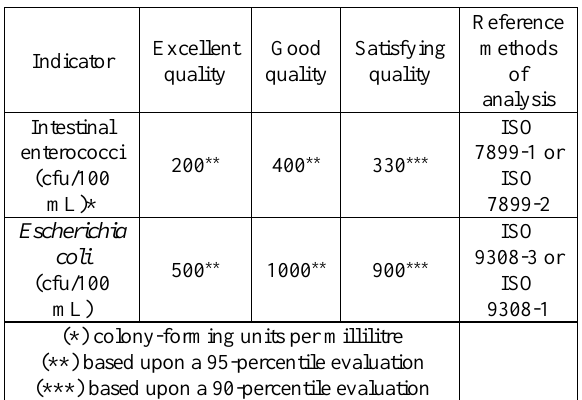
Table 1. Bathing water quality monitoring parameters - inland waters